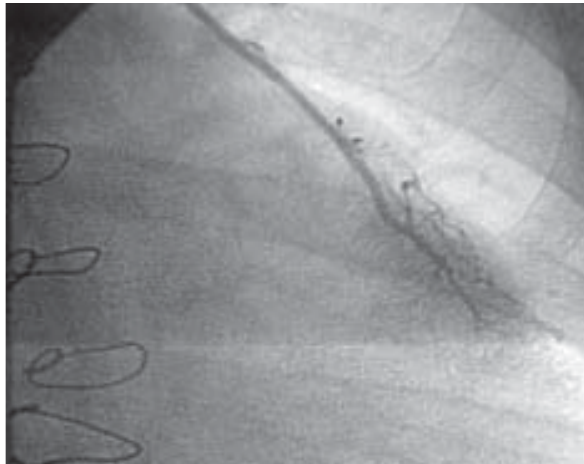
Fig. 3 - Angiographic study of a left internal thoracic artery implanted in the muscle of the left ventricle. Observe the formation of collateral circulation with the myocardial sinusoids.